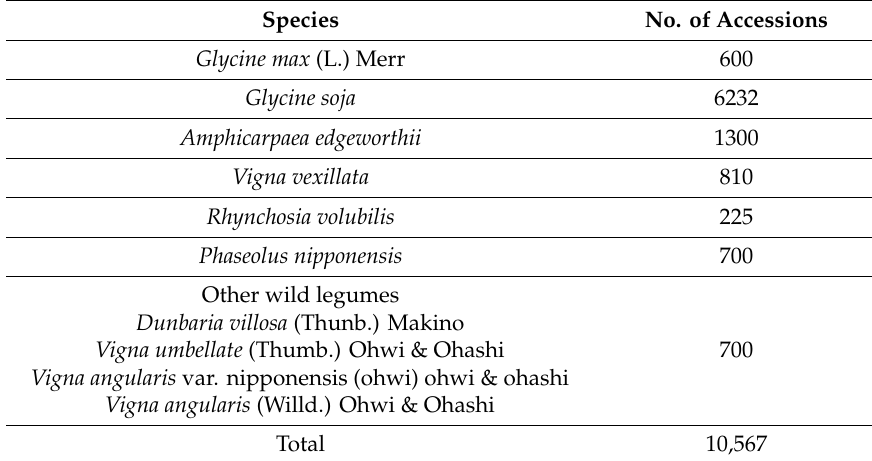
Table 3. List of wild legume germplasm accessions at Chung’s Wild Legume Germplasm Collection. Species No. of